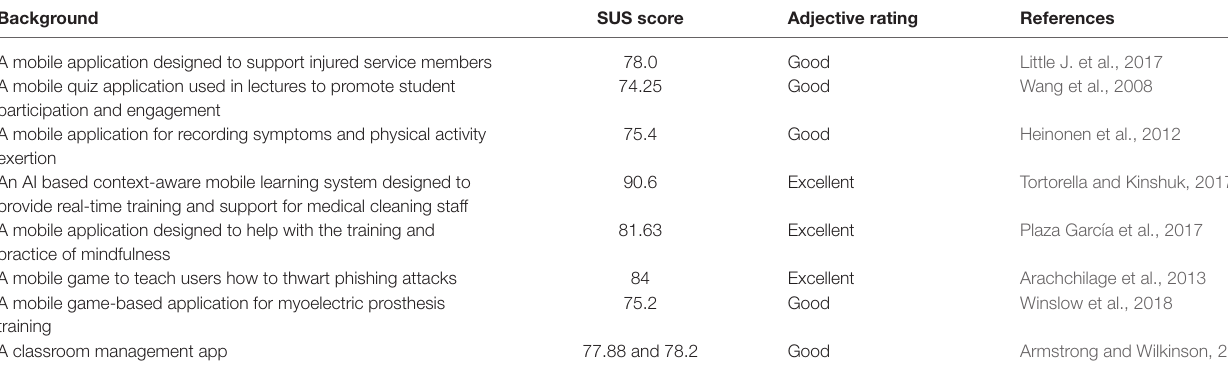
TABLE 1 | Studies which utilise the SUS to assess the usability of mobile applications.